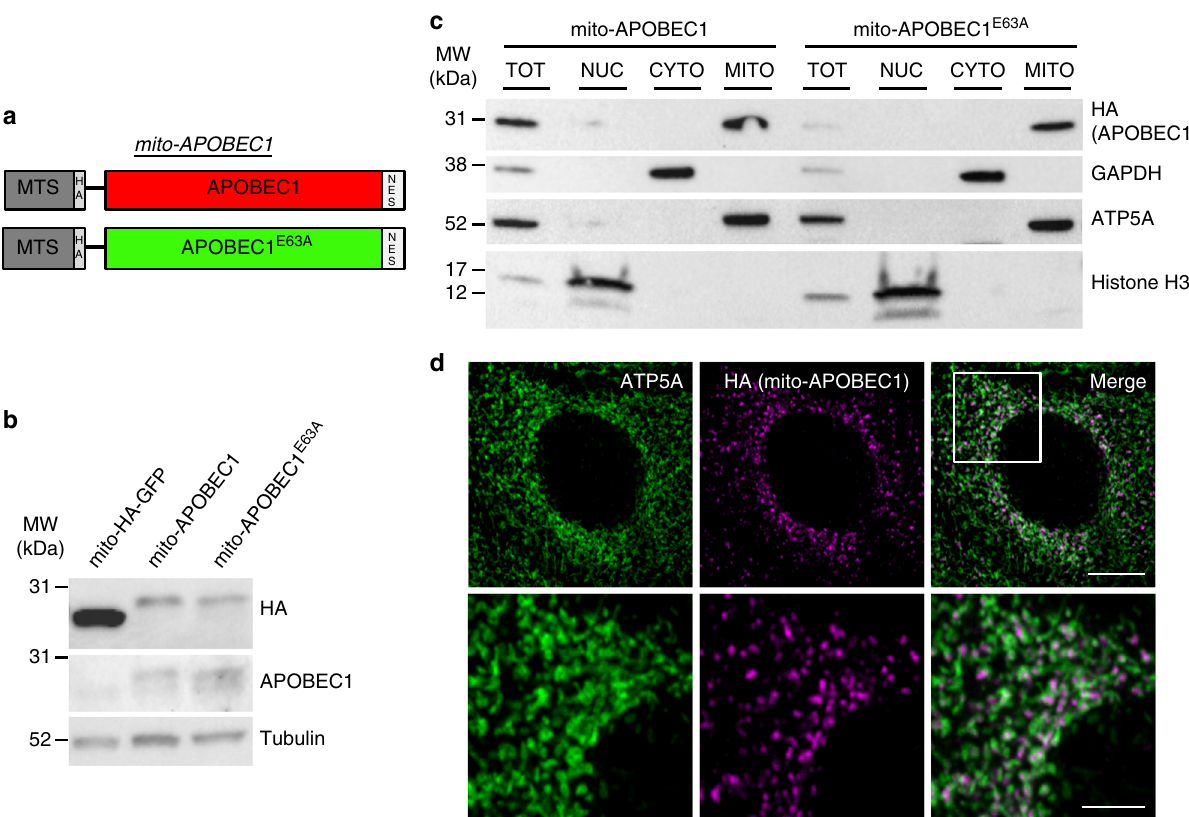
Fig. 2 Generation and validation of the mito-APOBEC1 mutator model. a Schematic of mito-APOBEC1 construct and inactive mutant (E63A). b Immunoblot showing mito-APOBEC1 transgene expression in whole fl y extracts, using anti-APOBEC1 and anti-HA antisera. Transgenic mito-HA-GFP expression is used as a positive control, and anti-Tubulin immunostaining as loading control. c Tissue fractionation and immunoblotting shows that mito-APOBEC1 and mito- APOBEC1 E63A proteins localise to the mitochondrial fraction (ATP5A-positive). GAPDH and Histone H3 mark the cytoplasmic and nuclear fractions, respectively. d Immunohistochemistry analysis of mito-APOBEC1 expression in larval epidermal cells, revealed by anti-HA staining, co-stained with the mitochondrial membrane marker ATP5A. Scale bars = 10 μ m (top panels) and 4 μ m (bottom panels). Source data are provided as a Source Data fi